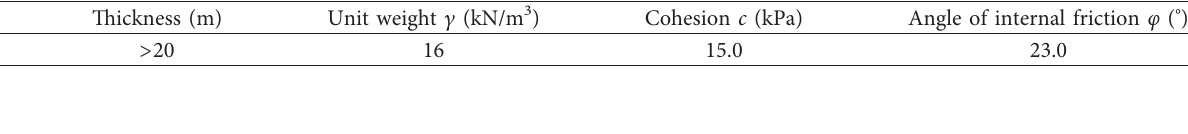
Table 1: Soil properties of the fill in the studied slope.